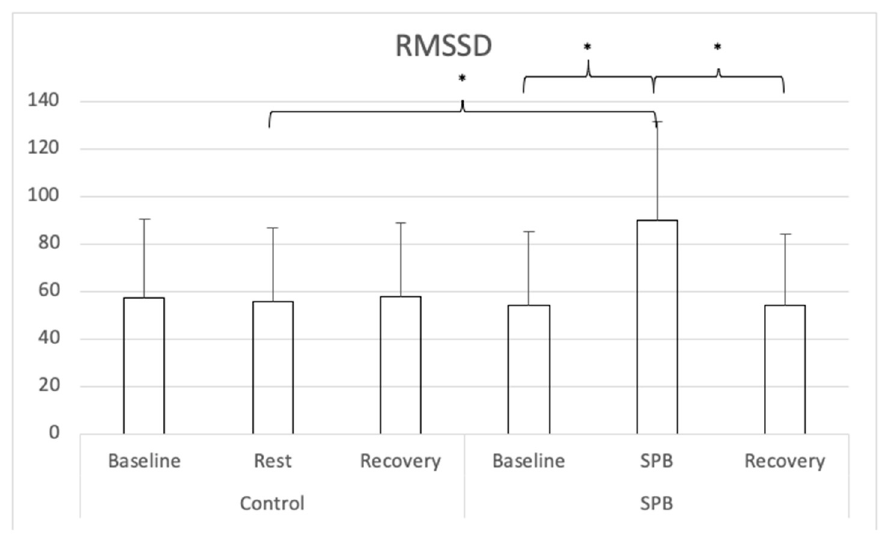
Figure 1. Root Mean Square of the Successive Differences. Note: SPB: Slow-paced breathing; * p < 0.006 (Bonferroni correction).